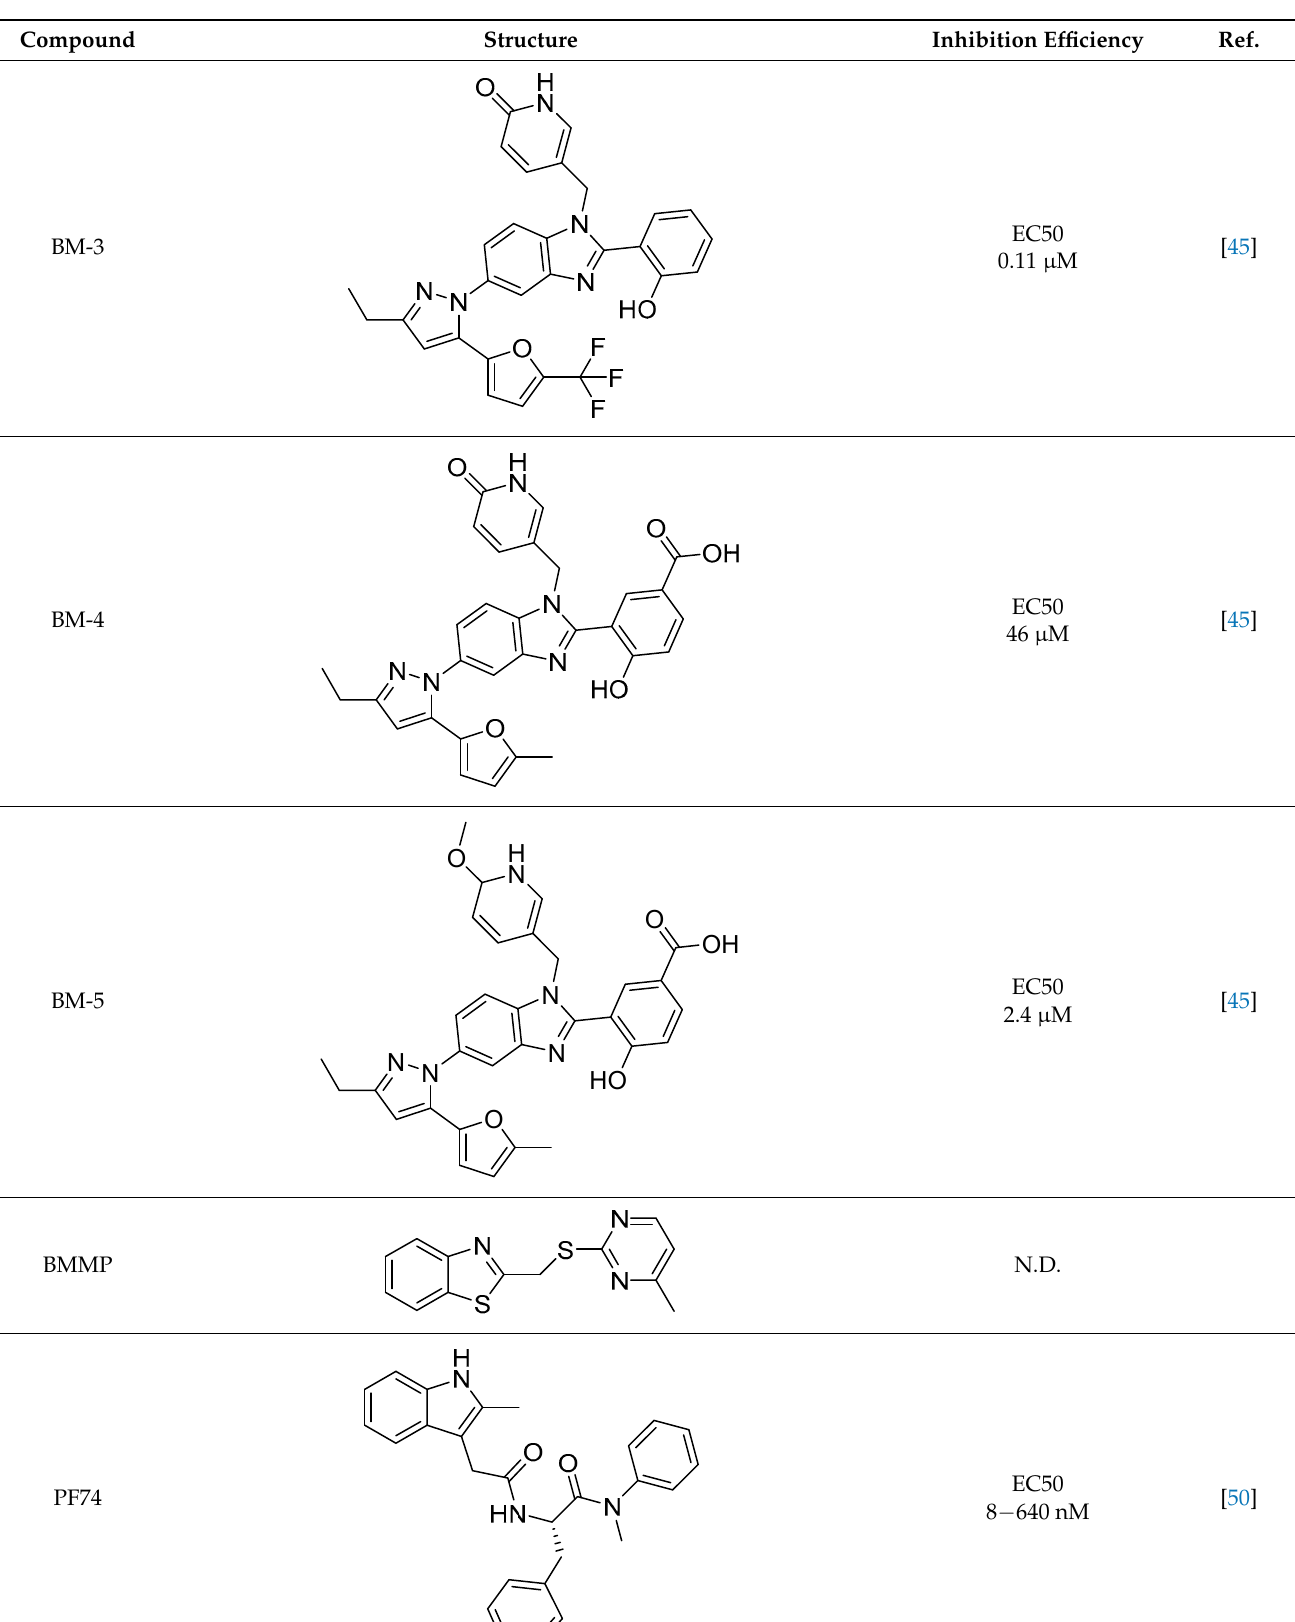
Table 1. Cont. Compound Structure Inhibition Efficiency